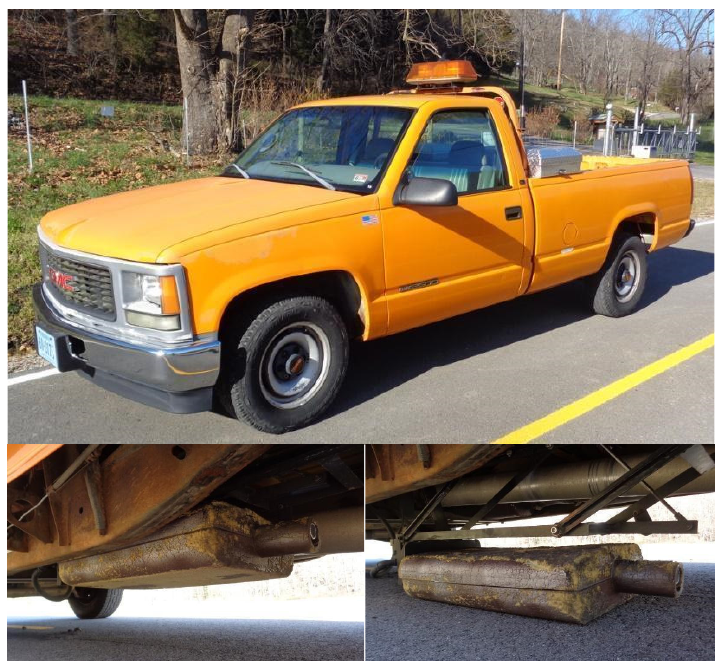
Figure 2. Second study vehicle capable of launching a fake foam rubber muffler.